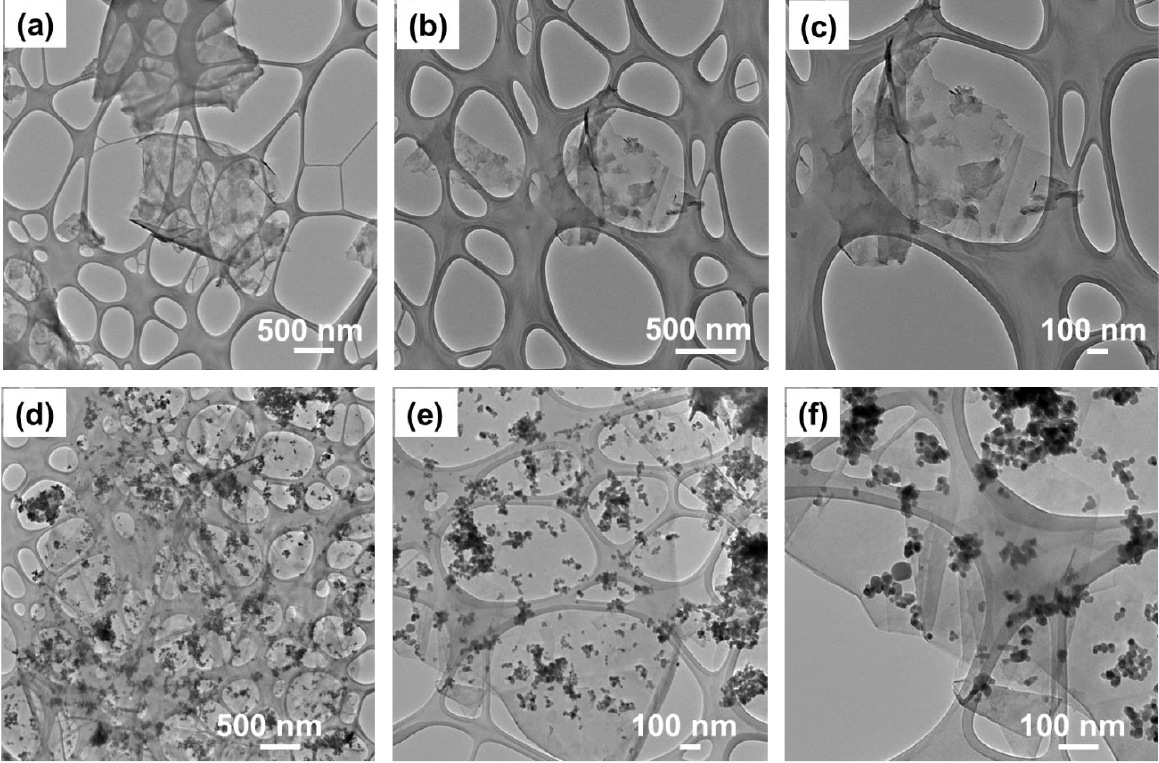
Figure 4. TEM images of GPSB ( a – c ) and GPSBI ( d – f ) with different